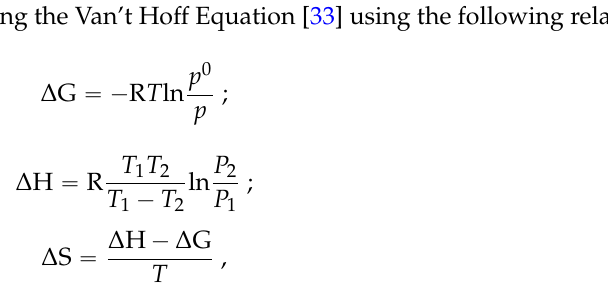
Table 4. Thermodynamic data for adsorption of CO 2 on SJA1, SJA2 and SJA4.